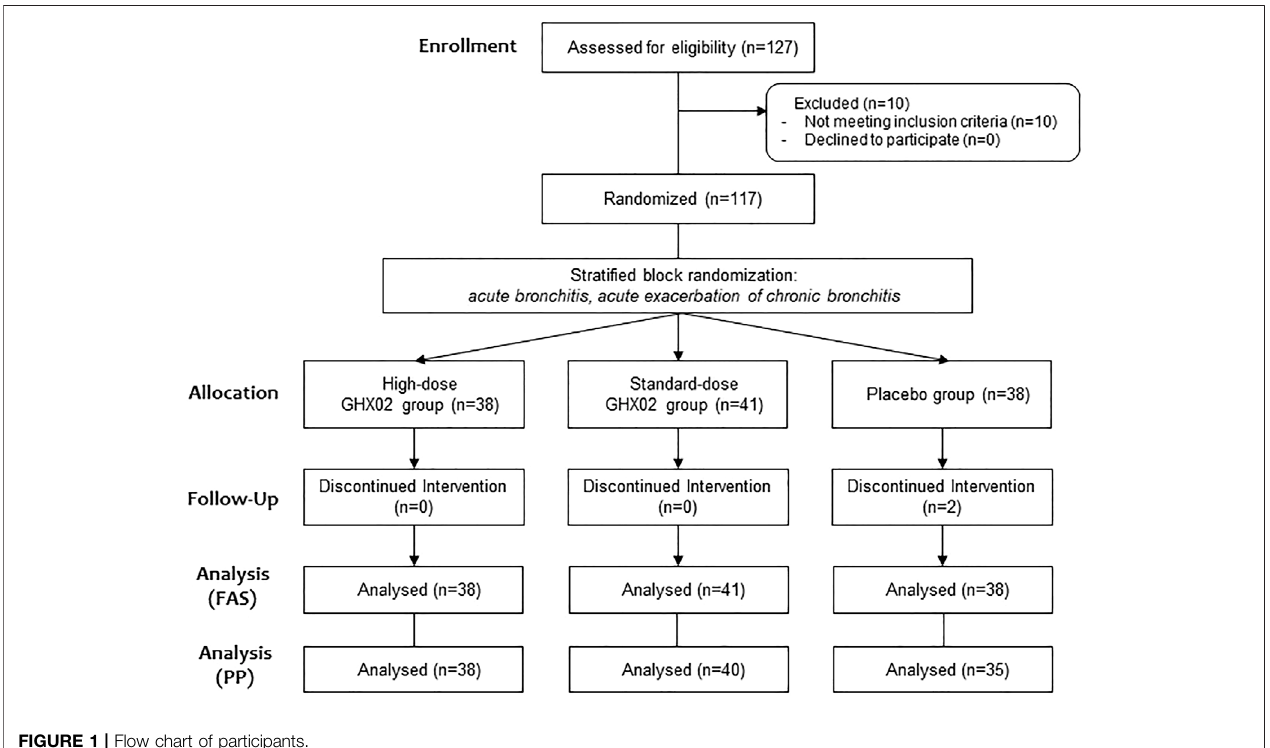
FIGURE 1 | Flow chart of participants.